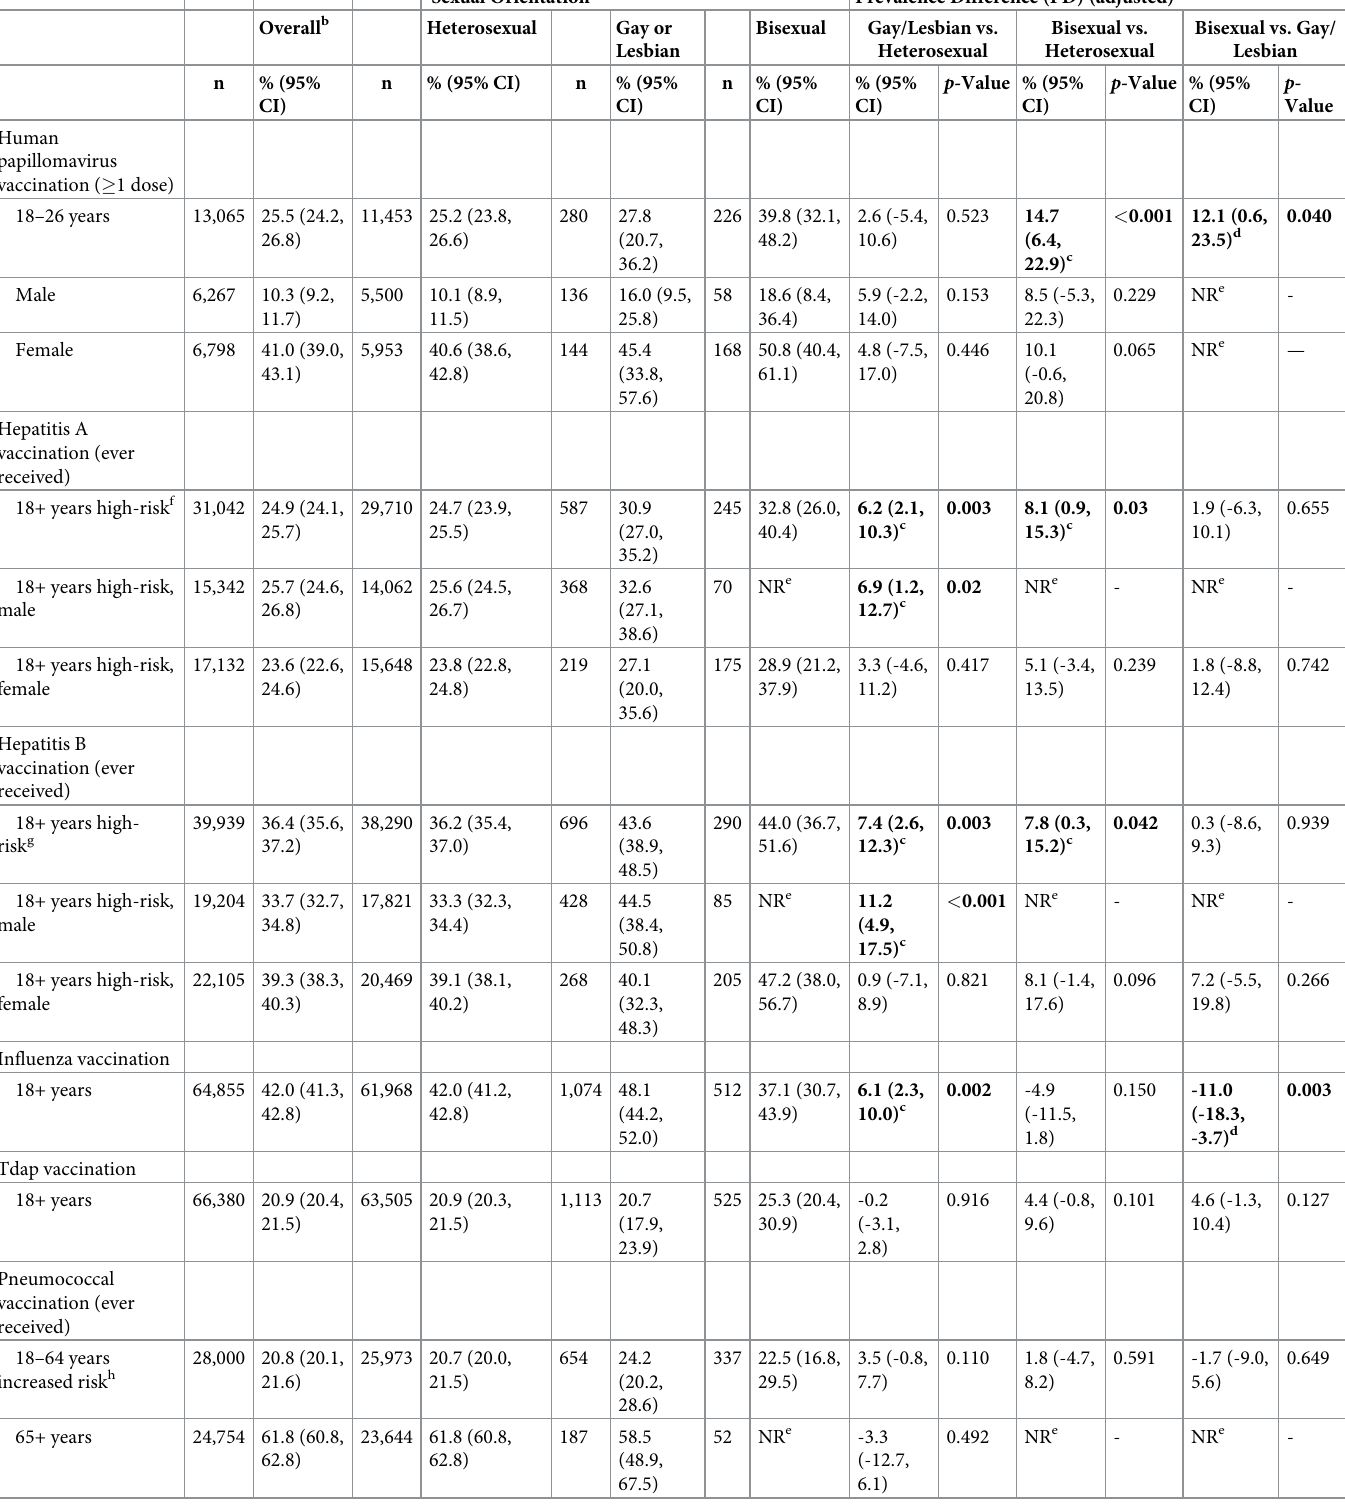
Table 3. Adjusted vaccination coverage of selected vaccines among adults aged � 18 years in the United States by self-identified sexual orientation–National Health Interview Survey, 2013–2015. Sexual Orientation Prevalence Difference (PD) (adjusted) a Overall b Heterosexual Gay or Bisexual Gay/Lesbian vs. Bisexual vs. Bisexual vs. Gay/ Lesbian Heterosexual Heterosexual